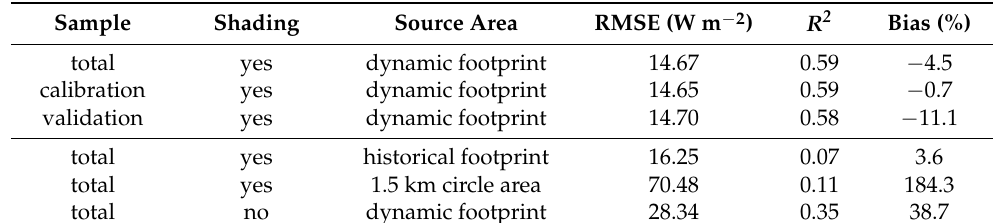
Table 1. Model performance for each scenario according to the metrics RMSE, R2, and relative bias for the PT-Urban model.